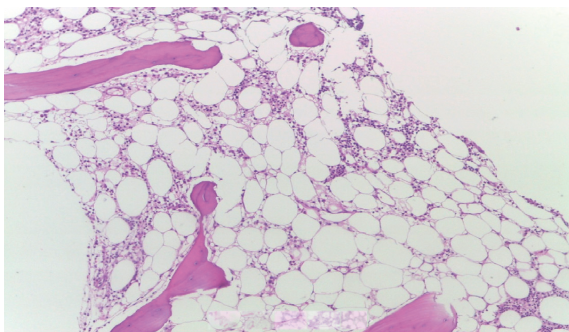
Figure 1: Fat-filled hypocellular bone marrow biopsy without fi- brosis or anomalous cell